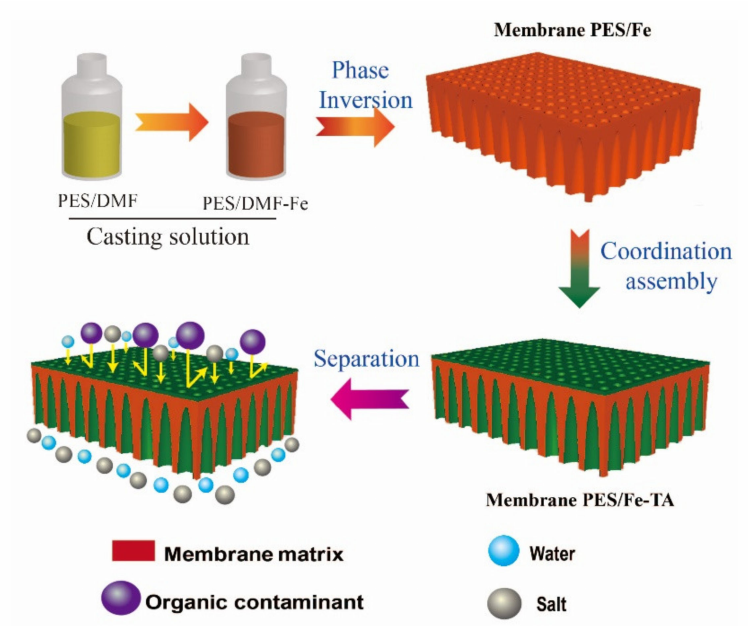
Figure 2. Schematic representation of the fabrication process of loss nanofiltration membrane and selective separation of dye and salt.